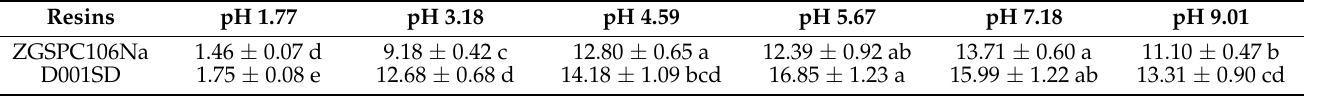
under different pH conditions. Caf